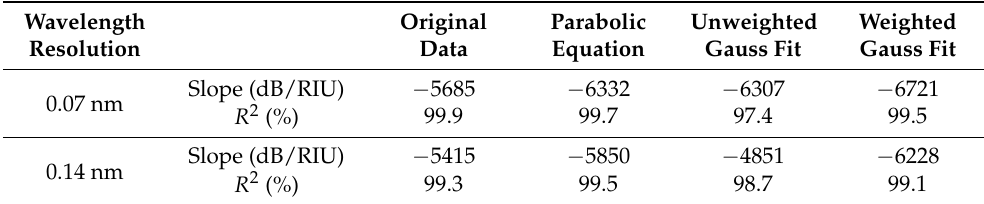
Table 1. Comparison of the slope and R 2 after linear regression of the amplitude of the cladding mode No. 10 resulting from original data, parabolic equation, unweighted, and weighted gauss